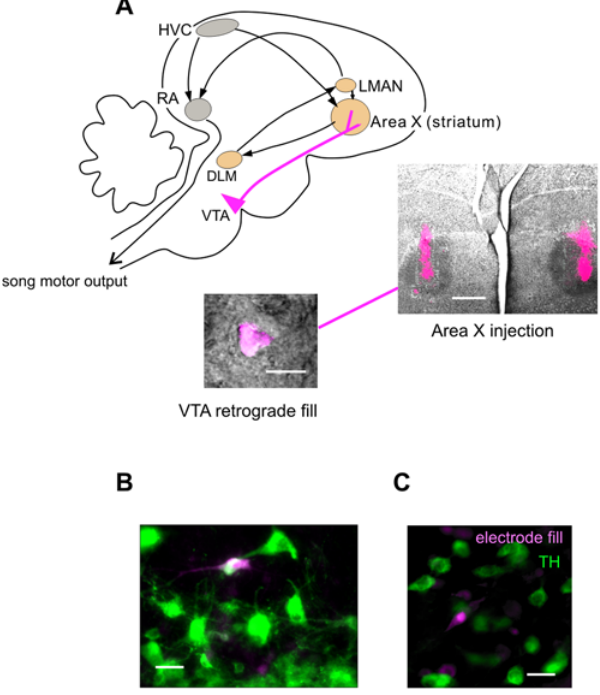
Figure 1. Anatomical identification of VTA cell types. (A) Schematic diagram of sagittal view of singing-related areas in the songbird brain. Motor control nuclei (gray) are critically involved in structuring song output, while nuclei of the anterior forebrain pathway (AFP, orange) are required for song plasticity, and appear to be involved in the communicative function of singing. Area X receives a especially strong dopaminergic input from VTA. Below right is an image of a representative bilateral tracer (Fluoro-ruby) injection in Area X. Image of fluorescent tracer (magenta) is overlaid on image of nissl stain in one brain section including Area X (darkly stained oval nucleus). To the left is an overlay of fluorescently labeled cell body retrogradely labeled by an injection in Area X with IR-DIC image visualized in living brain slice. Scale bars indicate 15 uM (left) and 750 uM (right). (B,C). Post-recording confirmation of cell type by immunohistochemistry and electrode-filling dye. Green label for tyrosine hydroxylase (TH) antibody is overlaid with magenta label of neurons filled with fluorescent dye from the recording electrode (Alexa 568, Molecular Probes) – white signal indicates overlap of two signals. Left panel presents example of post-recording confirmation of TH-positive dopaminergic neuron, and right panel shows example of recording from TH-negative presumptive gamma- aminobutyric acid (GABA) -ergic neuron. Scale bars indicate 30 uM.